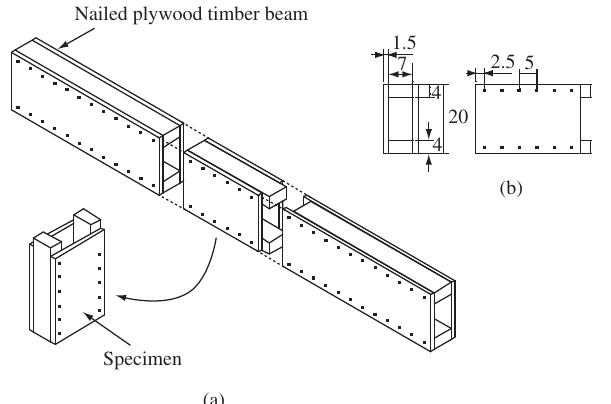
Figure 6. Scheme of the specimen a) obtaining the specimen from the beam and b) specimen dimensions.